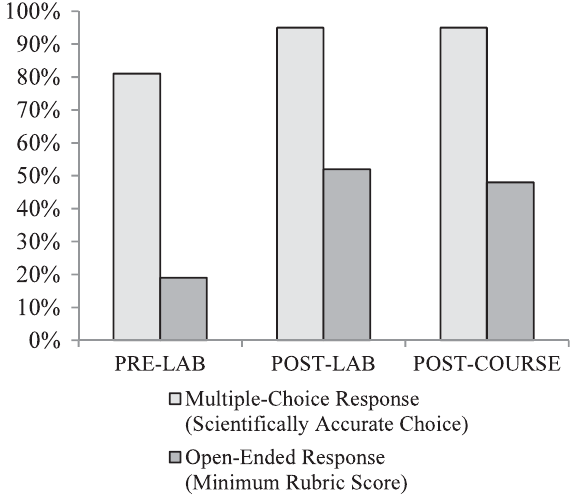
FIG. 5. Percentage of students meeting minimum criteria when asked whether or not the same stars are visible in an observer ’ s night sky six months apart ( n ¼ 21 ).